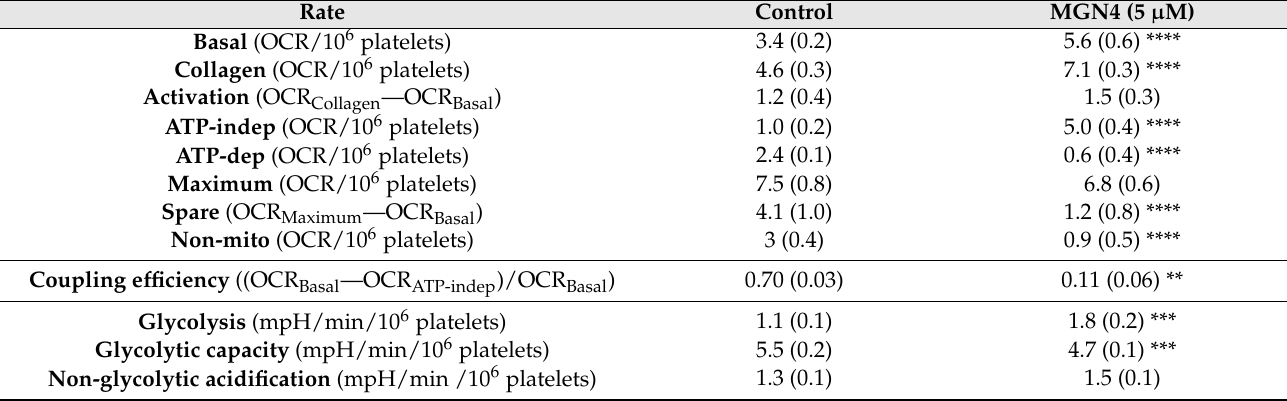
Figure 5. Effect of MGN4 on platelet mitochondrial function. ( A ) Representative profile of oxygen consumption rate (OCR) of platelets (25 × 10 6 cells/well). OCR was measured in a Seahorse XFe24 extracellular flux analyzer (Agilent, Santa Clara, CA, US) before and after the sequential addition of 3 µ g/mL collagen, 2.5 µ M oligomycin, 1.4 µ M FCCP, and 2 µ M/2 µ M rotenone/antimycin A. ( B ) Representative profile of extracellular acidification rate (ECAR) of platelets (25 × 10 6 cells/well). ECAR was measured in a Seahorse XFe24 extracellular flux analyzer before and after the sequential addition of 3 µ g/mL collagen, 10 mM glucose, 2.5 µ M oligomycin, and 100 mM 2-DG. Data are the means ± SD (n ≥ 3). The experiment was repeated for two different donors and the results were similar (not shown). Table 2. Quantification of respiration and acidification rate parameters.